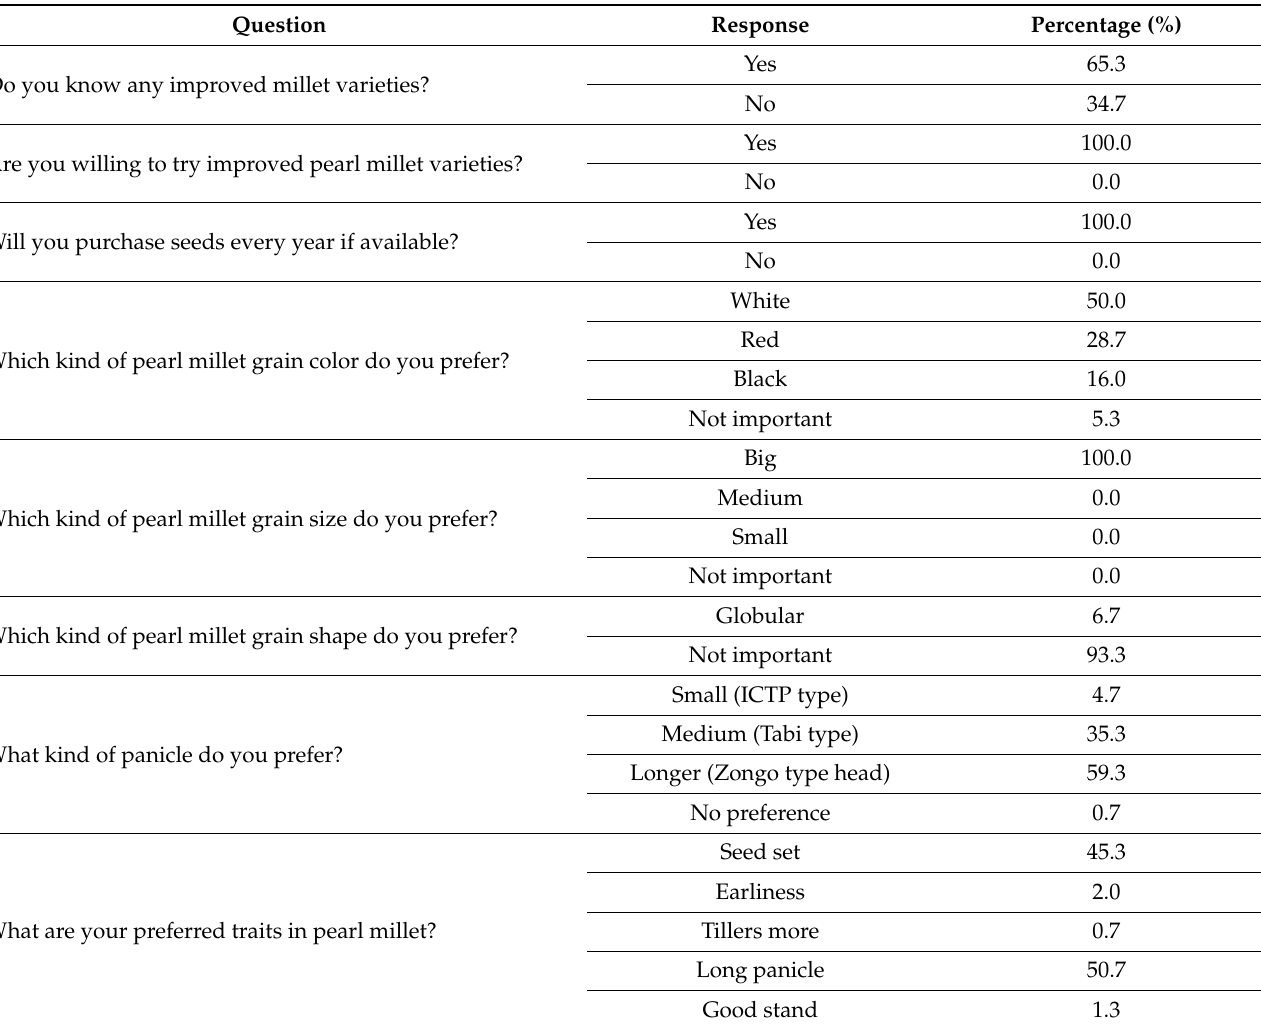
Table 4. Farmers’ pearl millet varietal and grain preferences in three departments (Dogondoutchi, Dosso, and Gaya) of the Dosso region in